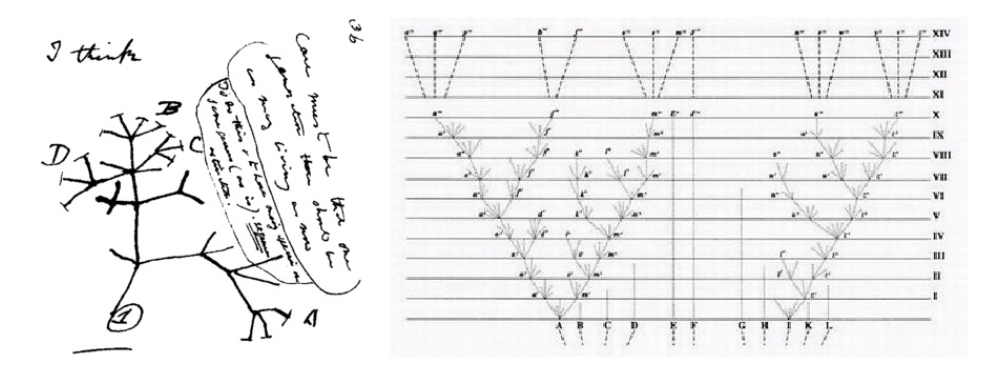
Figure 3. Evolutionary trees (precursors to the modern phylogenetic tree) drawn by Charles Darwin in 1837 ( left ) and 1859 ( right